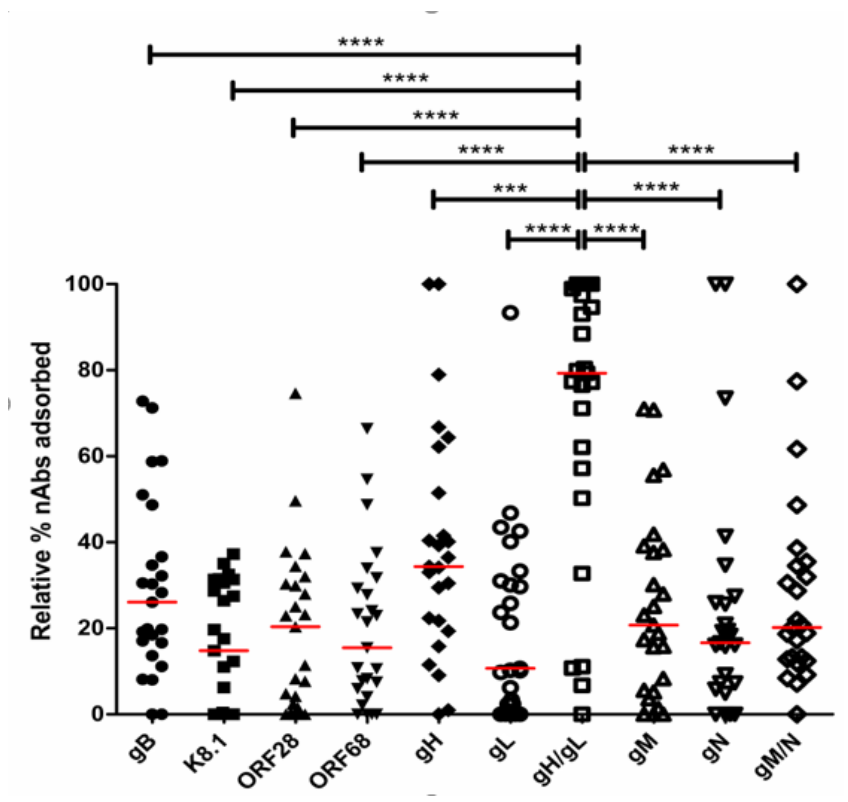
Figure 4. Comparison of nAbs responses among various KSHV envelope glycoproteins. The gH/gL complex-specific nAbs response was compared with other KSHV glycoproteins among all the participants using the Mann–Whitney test (*** p < 0.001, **** p < 0.0001).